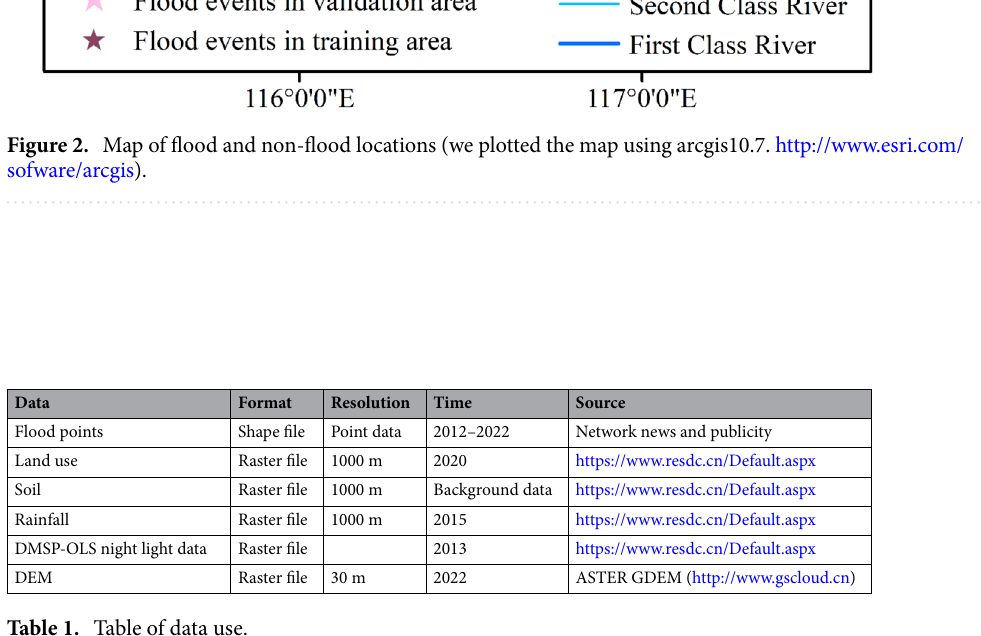
Table 1. Table of data